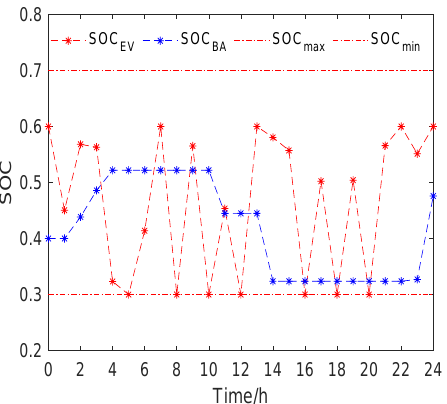
Figure 9. The battery and EV SOC under the objective function solving by MA.